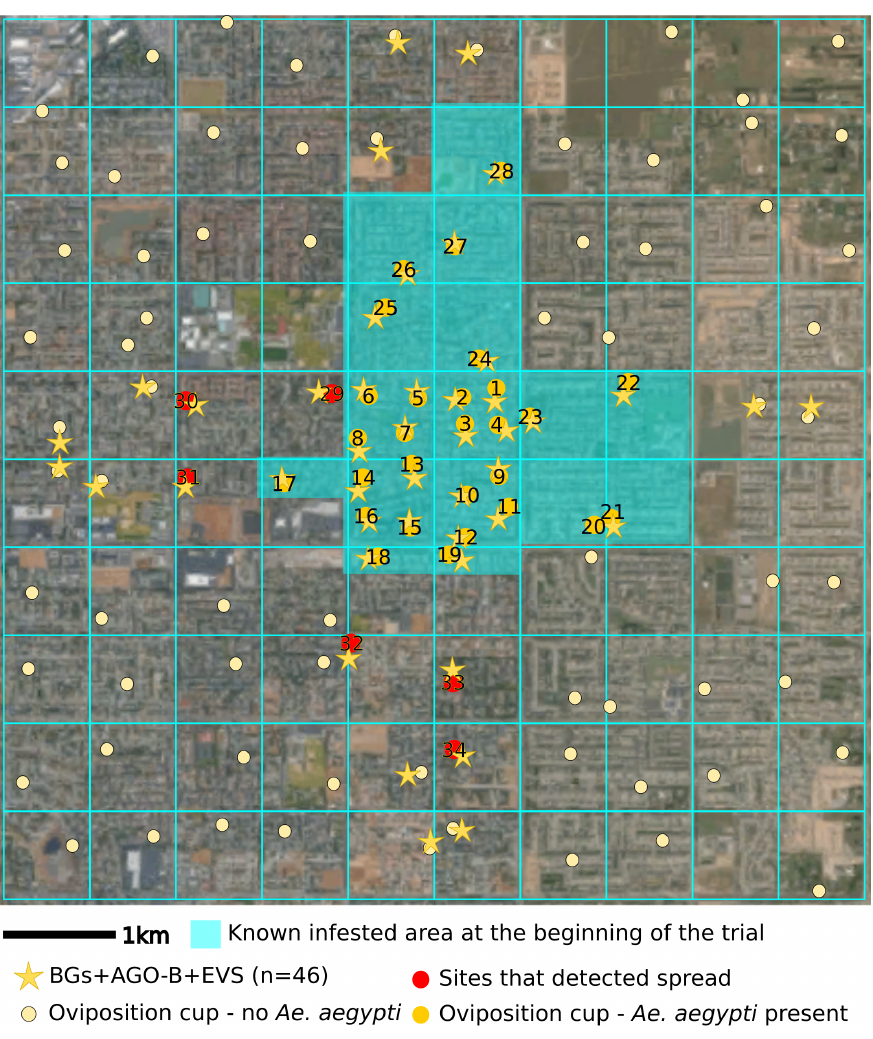
Figure 1. Layout of traps in a 10 × 10 cell grid covering 16.5 km 2 to evaluate trap types. Locations of oviposition cups are represented by dark circles and AGO-Bs as stars. The blue shaded area corresponds to the area where Ae. aegypti were present at the start of the evaluation (infestation area). Traps are marked in red circles where Ae. aegypti were collected after commencement of the study, showing dispersal. Numbers correspond to trap site locations. Detailed trap count data for each of the 34 sites that collected mosquitoes at least once during the trial are provided in Supplementary figures